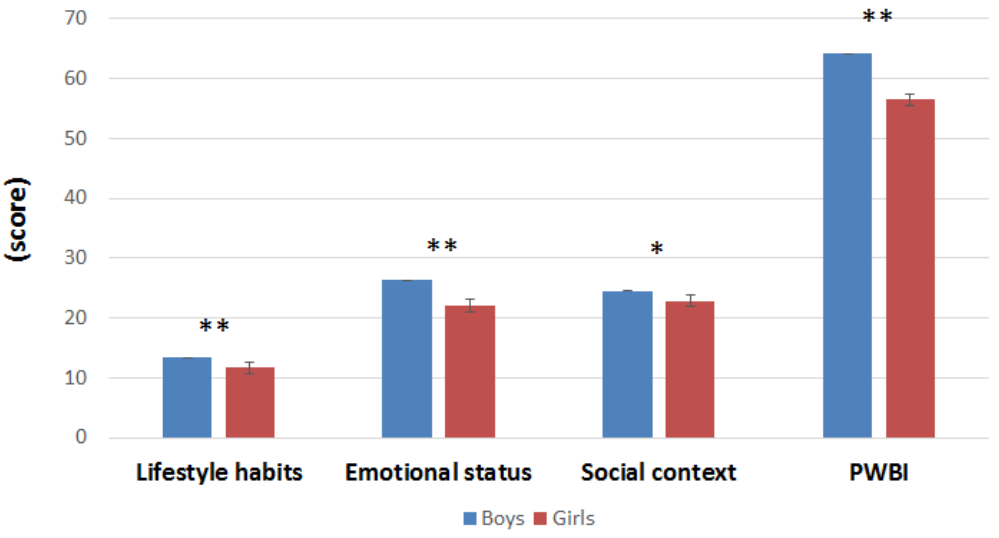
Figure 1. Gender differences in Psychological Well-Being Index (PWBI) and its components. Data given as mean ± SD (95% CI). * p < 0.05; ** p < 0.001